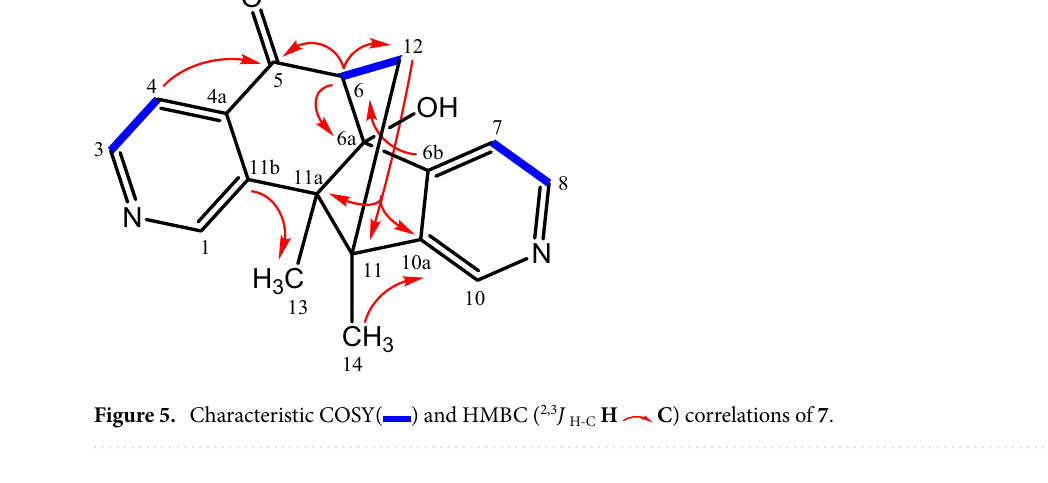
H-12a with H-5a; and H-14 (Me) with H-1 and H-10 (Fig. 4). In conclusion, compound 6 has been assigned as (5 R* ,5a R* ,10b S* ,11 R* )-5-hydroxy-10b,11-dimethyl-5,5a,10b,11-tetrahydro-6 H -5,11-methanopyrido[3’,4’:3,4] cyclopenta[1,2- g ]isoquinolin-6-one. Compound 6 is a new compound that has been obtained from C. mongolica for the first time. Compound 7 : (6 S* ,6a R* ,11 R* ,11a S* )-6a-Hydroxy-11,11a-dimethyl-6,6a,11,11a-tetrahydro-5 H -6,11-meth- anopyrido[3’,4’:4,5]cyclopenta[1,2- h ]isoquinolin-5-one. Compound 7 is a colorless solid and was obtained as a small by-product during the extraction of compound 6 . The ESI-MS ( m/z = 293.2 [M + H] + ) corresponds to the molecular formula C 18 H 16 N 2 O 2 . The 1 H NMR spectrum of 7 exhibited 11 signals for 16 protons (Table 3): four doublets and two singlets for the six pyridine protons, one doublet for the methine proton, two doublets of methylene bridge, and two singlets for the two methyl groups. The 13 C NMR spectrum showed signals for 18 carbon atoms (Table 3): ten carbon atoms of the two pyridine rings, one carbonyl group (202.52 ppm), one methine group (64.12 ppm), three quaternary carbon atoms, one methylene group (57.36 ppm), and two methyl groups. The assignment of the NMR signals and the structural elucidation of compound 7 are based on the COSY, HSQC, and HMBC spectra (Fig. 5). The COSY spectrum shows a cross peak between the protons of the meth- ylene bridge (H-12) and the proton of the methine group (H-6). The structural assignment is supported by the following series of HMBC correlations: H-4 with C-5; H-6 with C-5, C-6a, C-6b, and C-11b; H-12 with C-6, C-11, C-6a, C-11a, C-6b, C-10a, C-7, and C-10; H-13 (Me) with C-11b, C-11a, C-11, and C-6; H-14 (Me) with C-10a, C-11, C-11a, and C-12. Compound 7 has been assigned as (6 S* ,6a R* ,11 R* ,11a S* )-6a-hydroxy-11,11a-dimethyl- 6,6a,11,11a-tetrahydro-5 H -6,11-methanopyrido[3’,4’:4,5]cyclopenta[1,2- h ]isoquinolin-5-one. Compound 7 is a new compound that has been obtained from C. mongolica for the first time. Compound 8 : 5,7-Dihydroxy-2-(4-methoxyphenyl)-4 H -chromen-4-one (5,7-dihydroxy-4’-methoxyflavone, acacetin). Compound 8 (23.6 mg) was obtained as colorless needles. The ESI-MS ( m/z = 285.1 [M + H] + ) corresponds to the molecular formula C 16 H 12 O 5 . The 1 H NMR spectrum shows signals for 10 protons including seven aro- matic protons and a methoxy group at δ 3.88 ppm. The 13 C NMR spectrum exhibits signals for 16 carbon atoms: seven aromatic methine (CH) groups, six aromatic carbon atoms, one olefinic carbon atom, a methoxy group at 55.94 ppm, and a carbonyl group at 181.20 ppm. The assignment was additionally supported by 2D NMR spectroscopy. Thus, the structure of compound 8 was confirmed as 5,7-dihydroxy-4’-methoxyflavone (acacetin) 8, 13, 16, 17 . This natural product was isolated for the first time from the aerial parts of C. mongolica . 1 H NMR (CD 3 OD, 600 MHz): δ 7.90 (d, J = 12.0 Hz, H-2’, 2 H), 7.07 (d, J = 12.0 Hz, H-3’, 2 H), 6.45 (s, H-3, 1 H), 6.16 (d, J = 1.9 Hz, H-8, 1 H), 5.98 (d, J = 1.9 Hz, H-6, 1 H), 3.88 (s, OCH 3 , 3 H). 13 C NMR, (CD 3 OD, 151 MHz): δ 181.20 (C-4), 163.73 (C-2), 162.75 (C-7), 161.76 (C-4’), 160.91 (C-5), 156.79 (C-9), 129.02 (C-2’, 2 C), 122.30 (C-1’), 115.51 (C-3’, 2 C), 104.05 (C-6), 103.19 (C-10), 102.99 (C-3), 97.97 (C-8), 55.94 (OCH 3 ). Compound 9 : Octahydro-5 H ,10 H -dipyrrolo[1,2- a :1’,2’- d ]pyrazin-5,10-dione (L-proline anhydride). Compound 9 (2.4 mg) was obtained as a colorless amorphous solid. The ESI-MS ( m/z = 195.2 [M + H] + ) and EI-MS ( m/z = 194 [M + ]) correspond to the molecular formula C 10 H 14 N 2 O 2 . The 1 H NMR spectrum displays six proton signals for six methylene groups and two methine protons. The 13 C NMR spectrum exhibits five signals for six methylene groups, two methine groups and two carbonyl groups. Therefore, compound 9 has been assigned as octahydro-5 H ,10 H -dipyrrolo[1,2- a :1’,2’-d]pyrazine-5,10-dione (L-proline anhydride). Compound 9 was isolated for the first time from the aerial parts of C. mongolica . 1 H NMR (CDCl 3 , 600 MHz): δ 4.18 (t, J = 18.0 Hz, H-4, 2 H), 3.53 (m, H-1, 4 H), 2.31 (m, H-3a, 2 H), 2.18 (m, H-3b, 2 H), 2.02 (m, H-2a, 2 H), 1.92 (m, H-2b, 2 H).